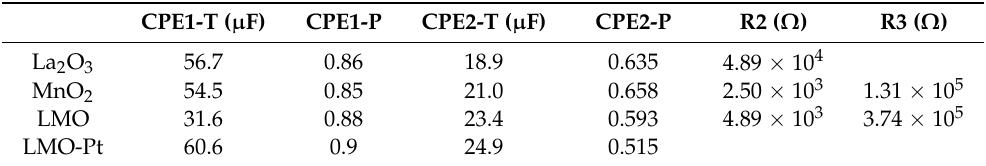
Table 2. Electrochemical impedance spectroscopy data for La 2 O 3 , MnO 2 , LMO, and LMO-Pt electro- catalytic materials in N 2 -saturated 0.10 M KOH gained at OCP.